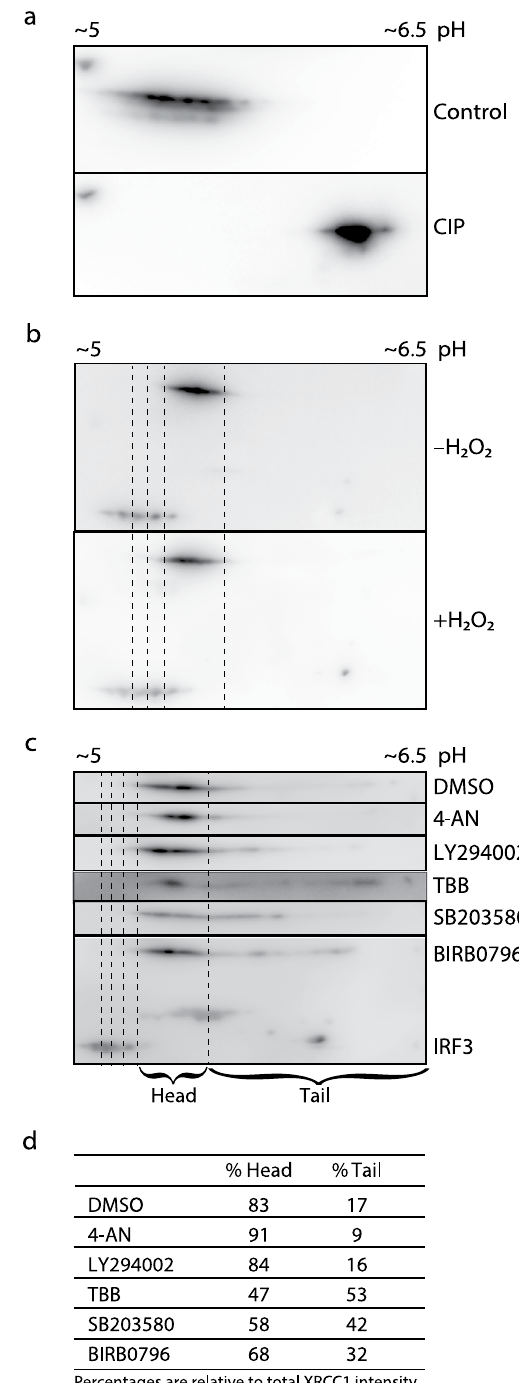
Figure 1. Phosphorylation state of endogenous XRCC1. ( a ) 2D-PAGE western analysis of immunoprecipitated endogenous XRCC1, mock treated (control) and calf-intestine phosphatase (CIP) treated immunoprecipitates. ( b ) 2D-PAGE western analysis of whole cell lysates from HeLa cells grown in parallel with and without addition of H